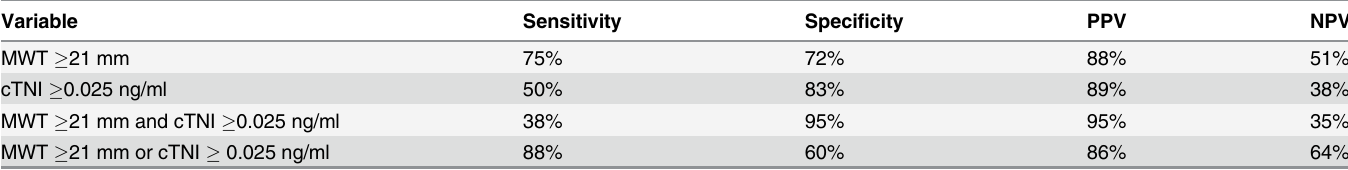
CTnI indicates cardiac troponin I; HOCM, hypertrophic obstructive cardiomyopathy; LGE, late gadolinium enhancement; MWT, maximum wall thickness; NPV, negative predictive value and PPV, positive predictive